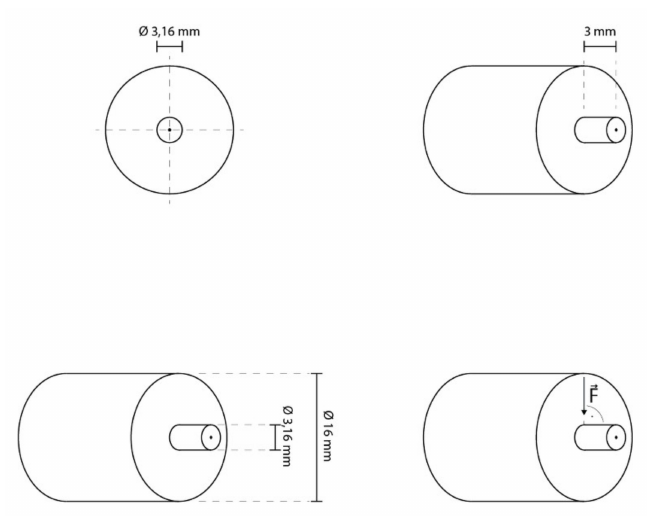
Figure 3. Graphics illustrating specimen dimensions and